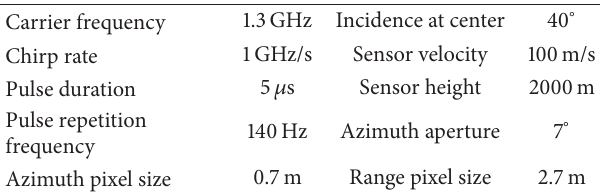
Table 3: Simulation